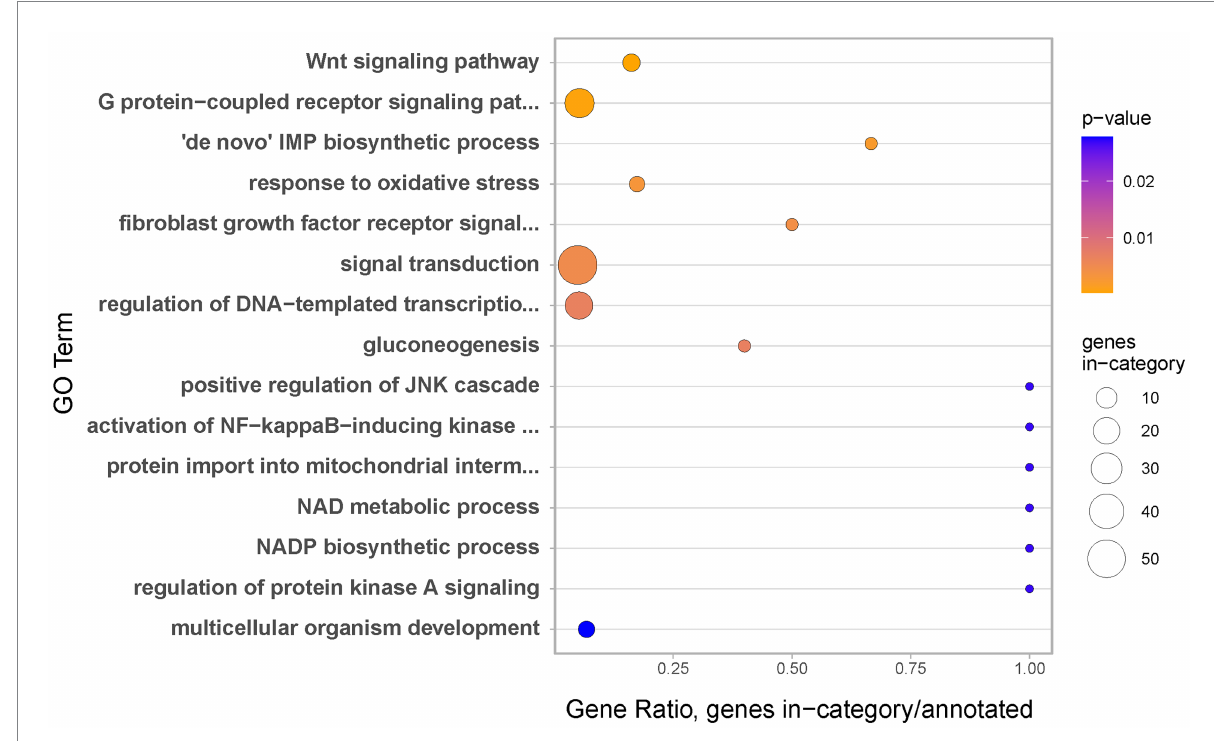
FIGURE 5 Biological Processes identified as gene ontology enriched terms in genes significantly upregulated at regeneration Stage 1 as compared to coenosarc.